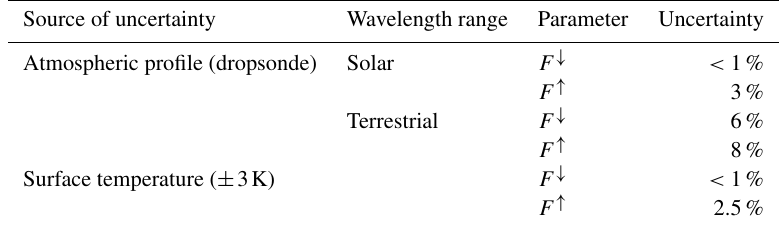
Table 1. Estimations of the uncertainty of the simulated cloud-free conditions based on different possible sources.